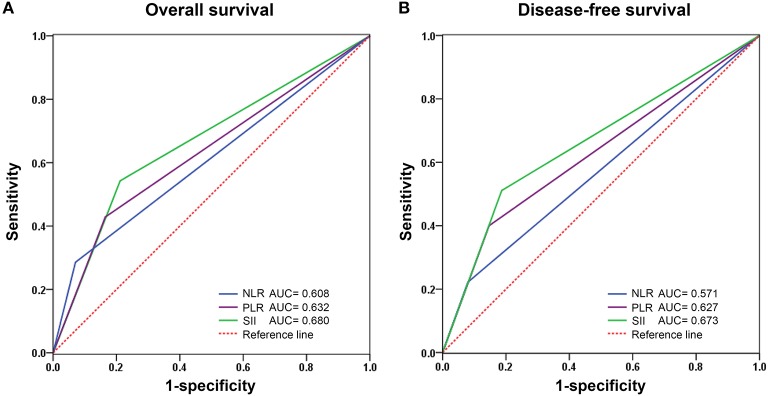
Predictive ability of SII compared with NLR and PLR for overall (A) and disease-free survival (B) by receiver operating characteristic (ROC) curve analysis in training cohort. NLR, Neutrophil-lymphocyte ratio; PLR, Platelet-lymphocyte ratio; SII, Systemic immune-inflammation index.